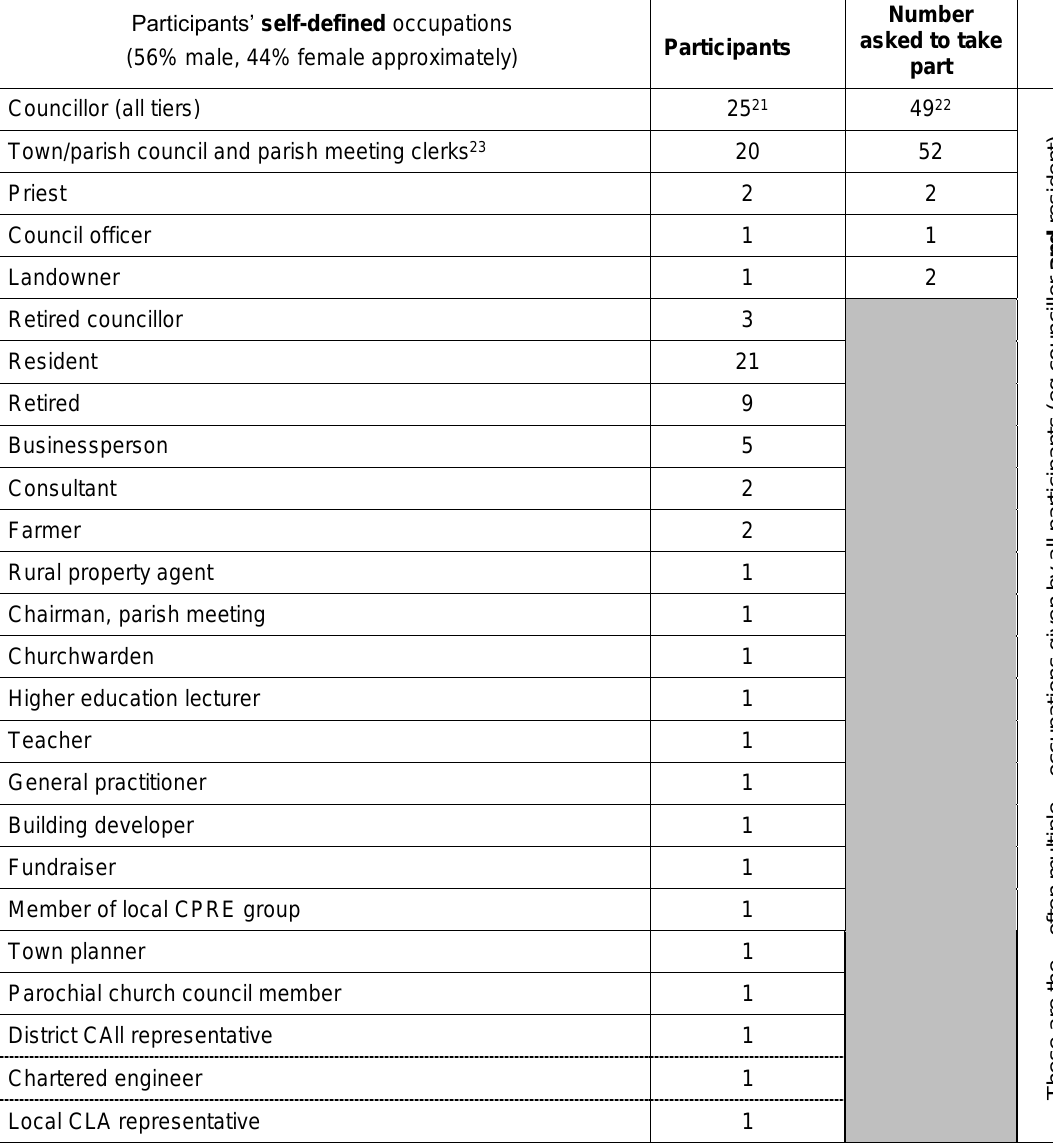
Table 4: Online survey participant information Participants’ self-defined